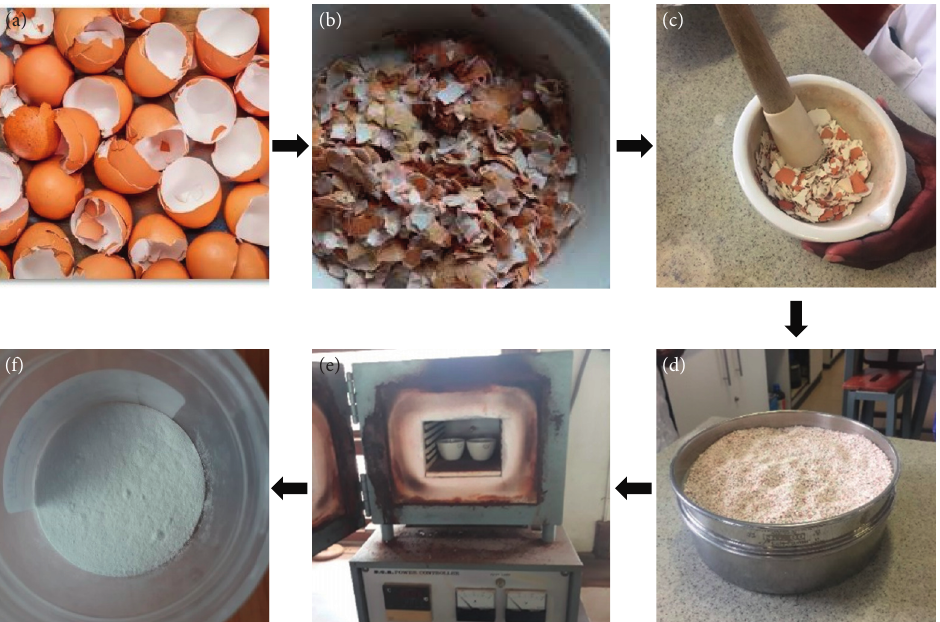
Figure 1: Powder preparation steps of calcined eggshells. (a) Eggshell. (b) Sun-drying. (c) Grinding. (d) Sieving. (e) Calcination. (f) Filtration.